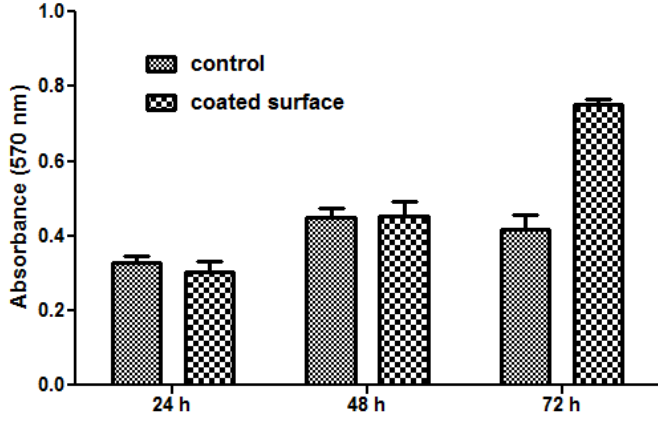
Figure 8. Graphic representation of the MTT results obtained by analyzing endothelial cells grown in the presence of control (uncoated G-tube) and Fe surfaces for 24, 48 and 72 h.